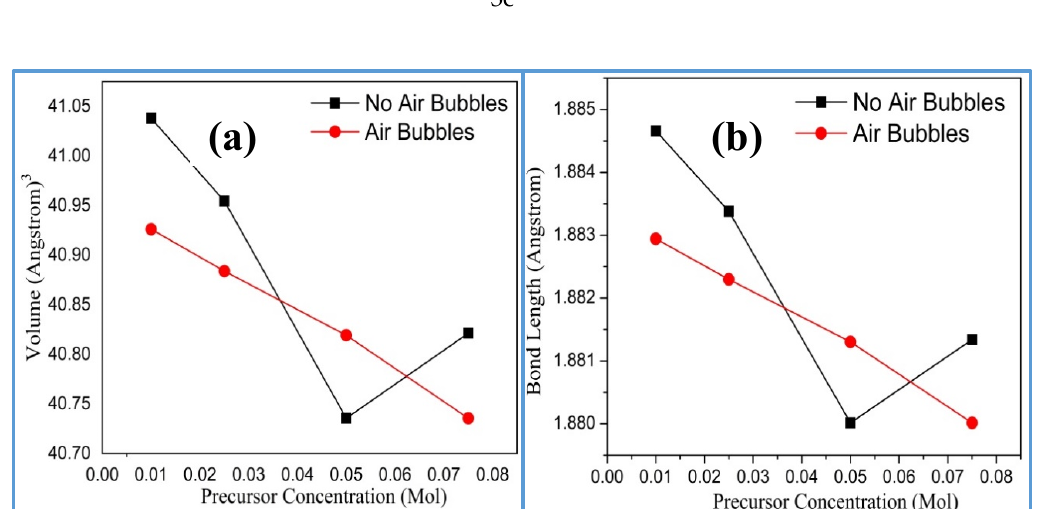
Figure 10. Effect of precursor concentration on ( a ) volume of hexagonal cell ( b ) bond length along diffraction peak (002) of synthesized ZnO nanorods in the presence and absence of air bubbles.